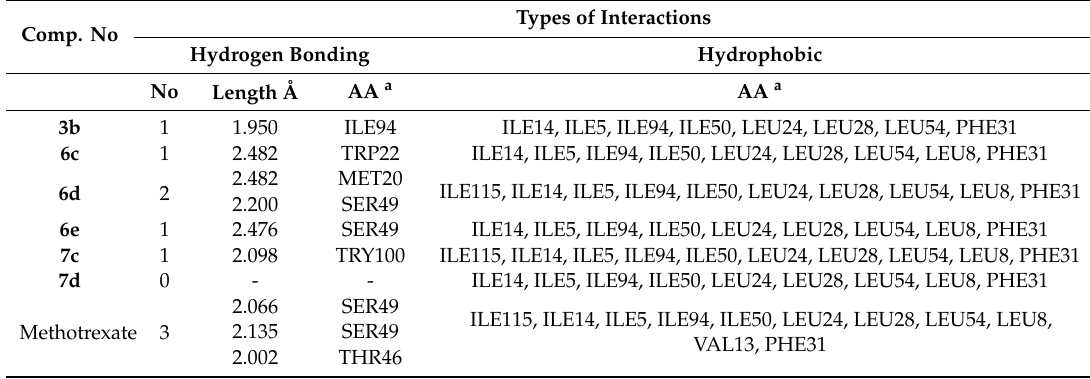
Table 5 . Hydrogen bond and hydrophobic interaction for the most promising tested compounds into DHFR binding pocket in comparison to the co-crystallized ligand.